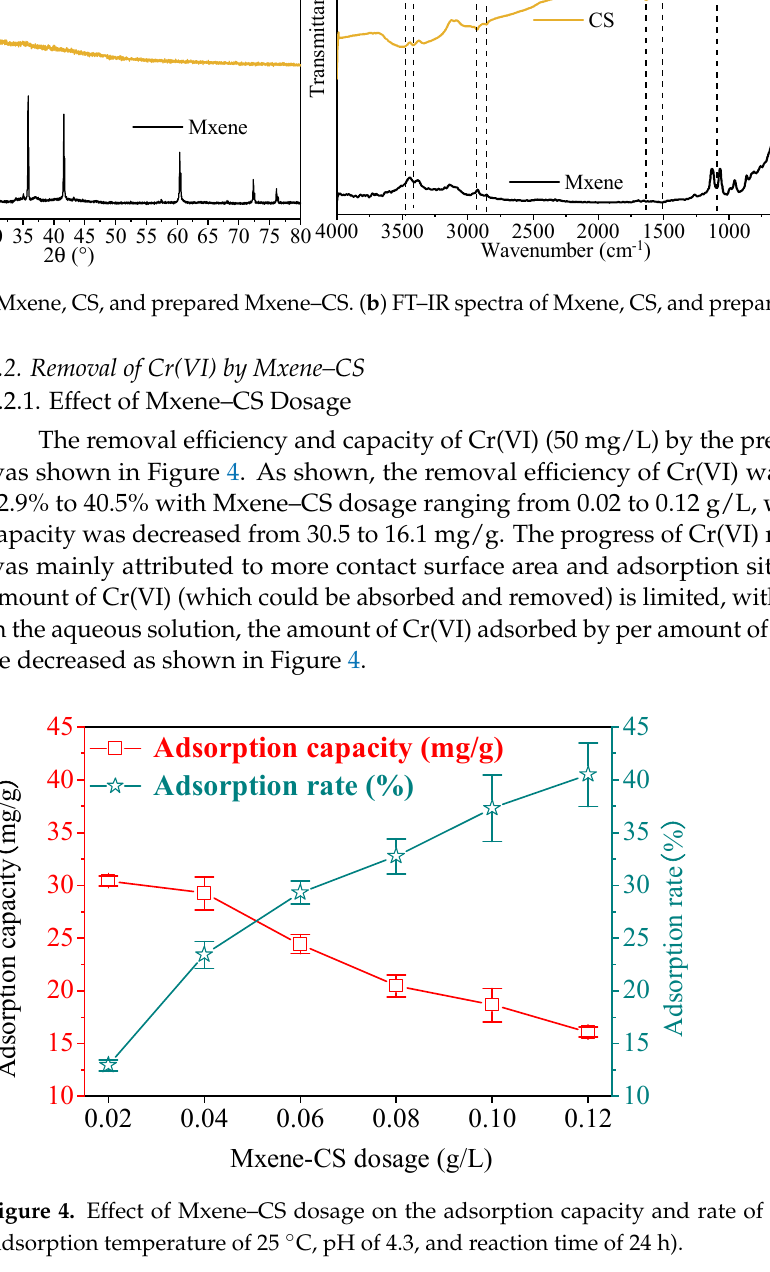
Figure 2. SEM images of the original Ti 3 AlC 2 ( a ) , the Mxene ( b ), CS ( c ), and prepared Mxene – CS ( d ).